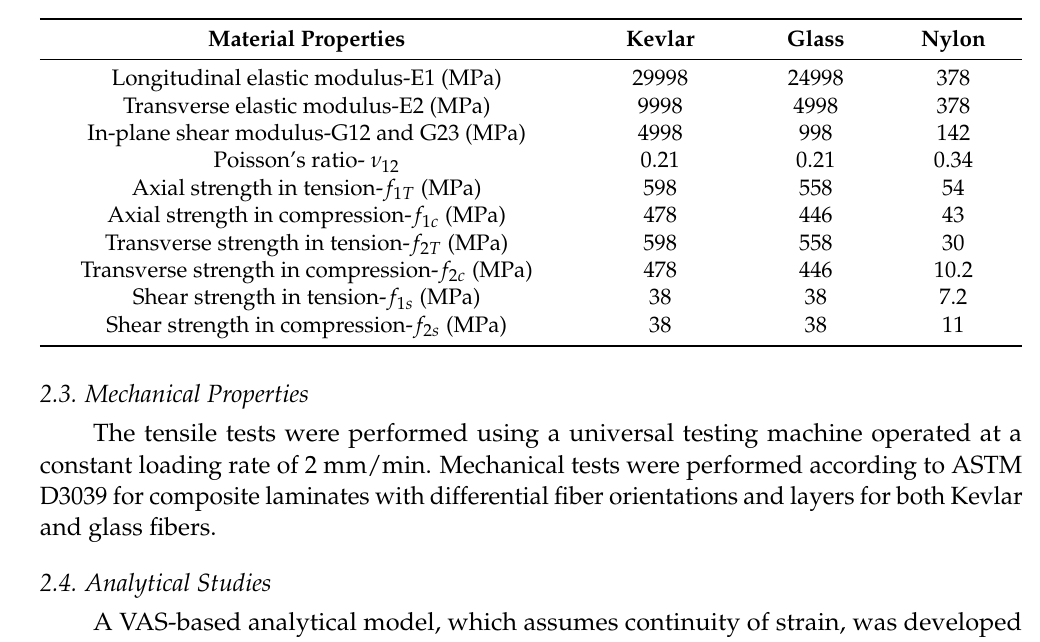
Figure 3. ( A ) Typical cross-section of the printed coupons, ( B ) 3D printer, and ( C ) stress–strain profiles generated using FEA for nylon/glass fiber and nylon/Kevlar composites. Table 1. Adopted elastic material properties of the printed materials.